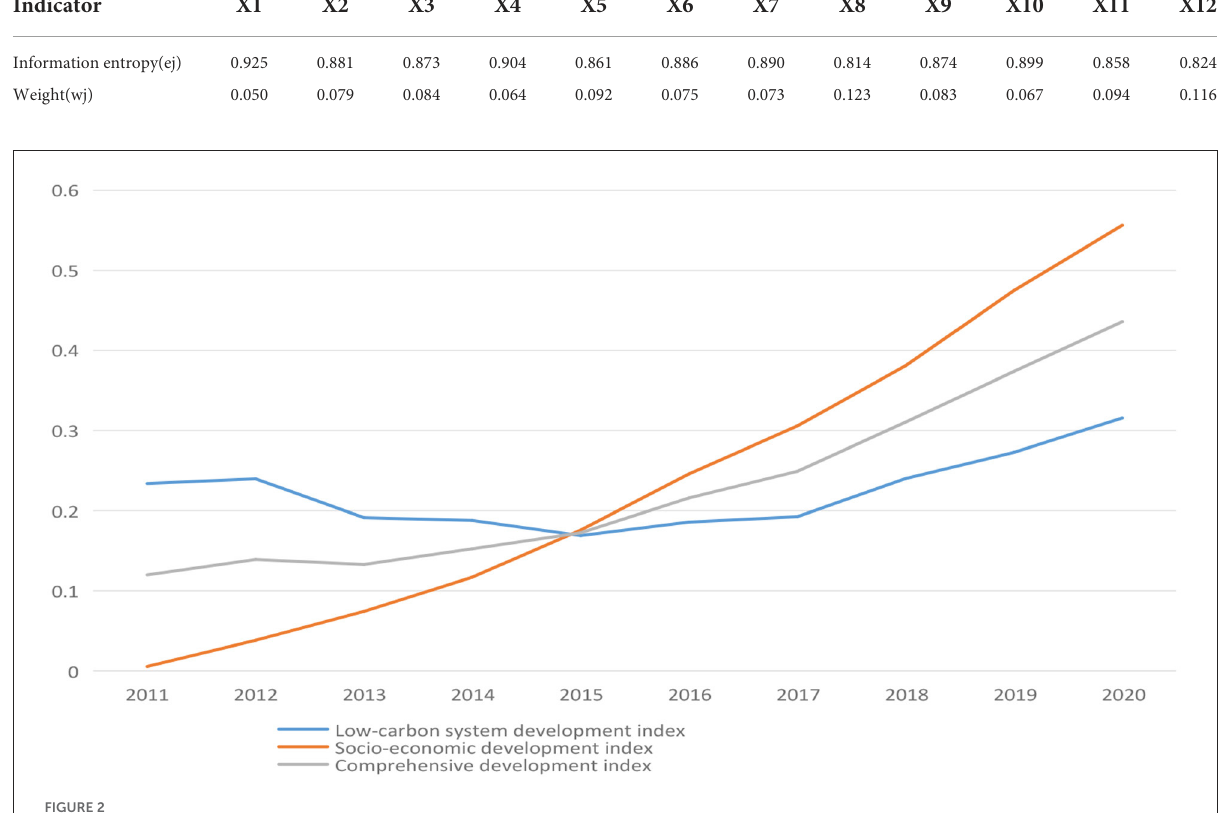
FIGURE2 Change trend in Anhui